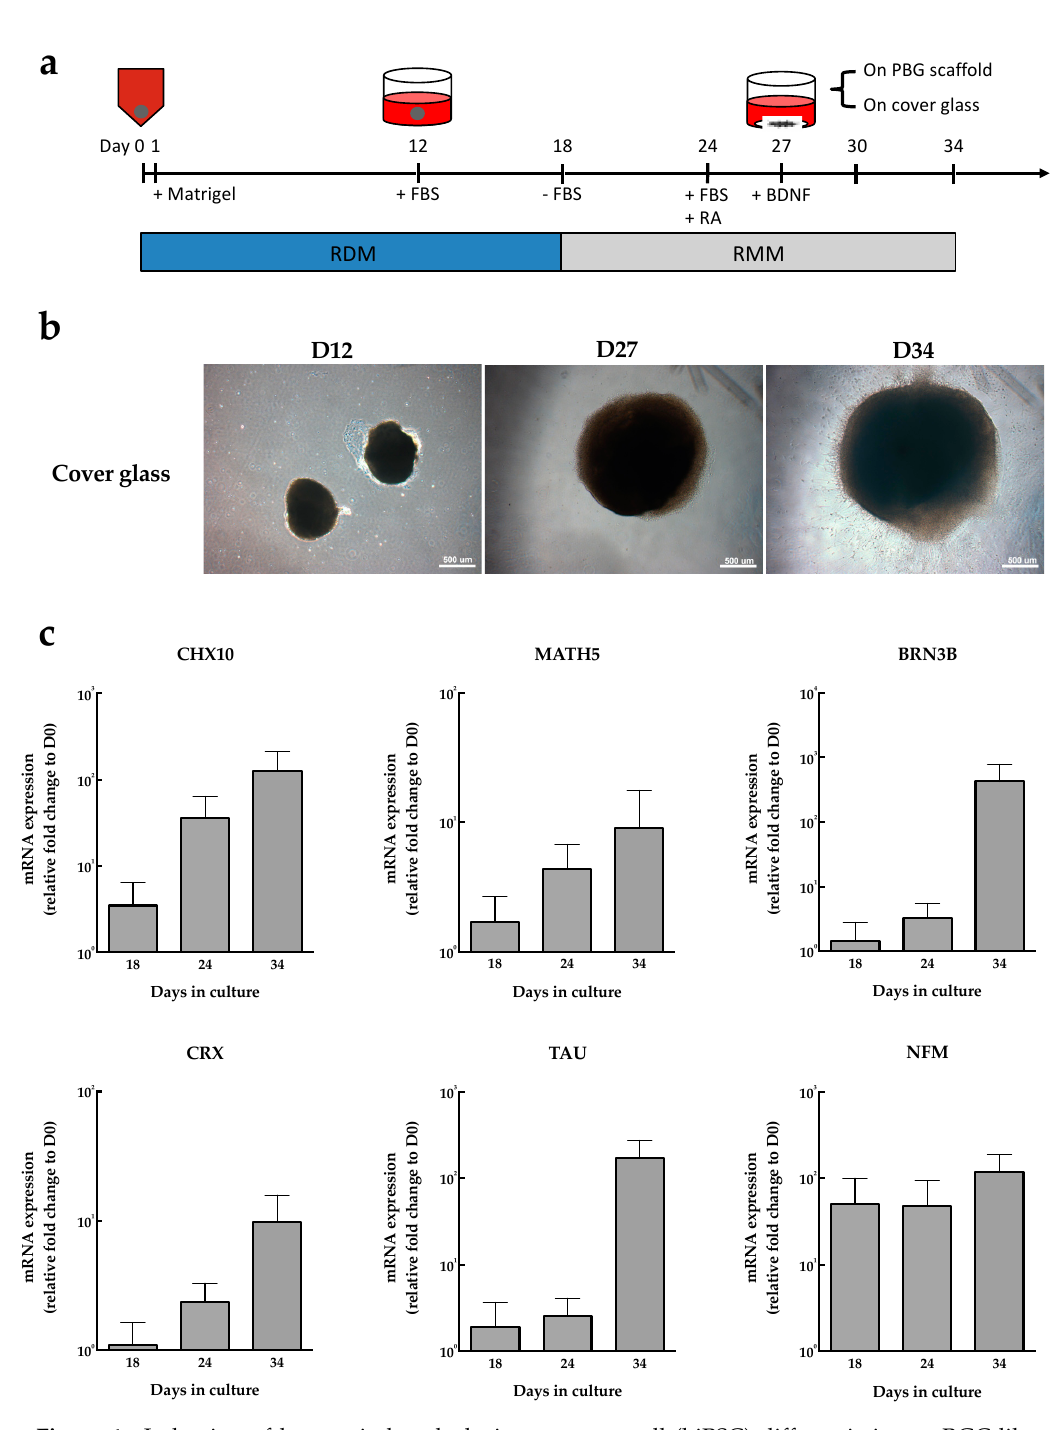
Figure 1. Induction of human-induced pluripotent stem cell (hiPSC) differentiation to RGC-like cells. ( a ) The flow chart of culture procedure of hiPSC-derived RGC-like cells. In brief, the hiPSCs were dissociated to single cells, and reaggregated to develop into embryoid bodies (EBs) in retinal differentiation medium (RDM) in V-bottomed low cell adhesion 96-well plate on Day 0, followed by adding 0.5% Matrigel on Day 1–18 and 1% FBS on Day 12–18. On Day 18, the culture condition was changed to retinal maturation medium (RMM), followed by addition of 1% FBS and 0.5 µ M retinoic acid in RMM on Day 24, and then the aggregates placed into adherent culture on Day 27 with RMM containing 100 ng/mL BDNF. ( b ) In vitro time-course images of neural spheres cultured on cover glass. Scale bar = 500 µ m. ( c ) The mRNA expression of RGC-associated genes at different time points of culture period. The relative mRNA expression of CHX10 , MATH5 , BRN3B , CRX , TAU , and NFM in hiPSC-derived RGC-like cells were analyzed on Day 18, Day 24, and Day 34, respectively.